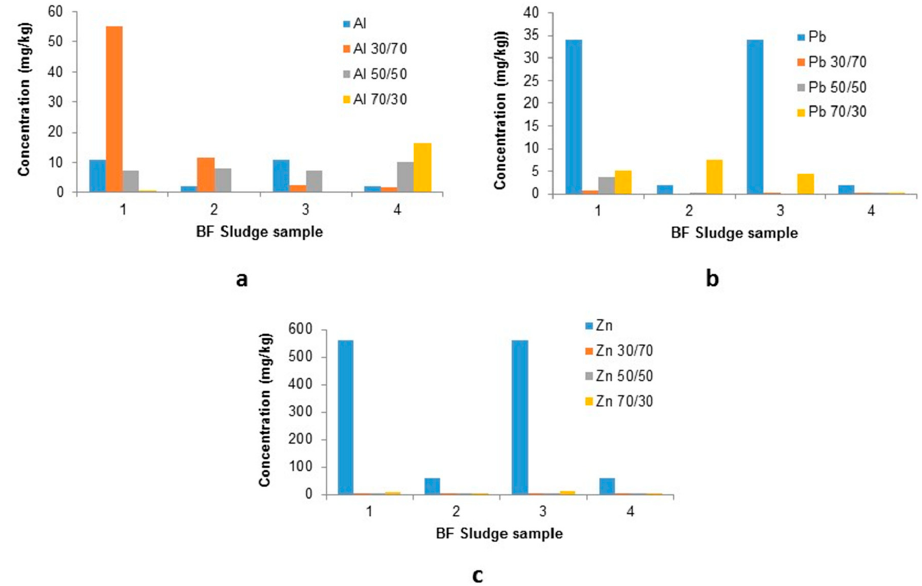
Figure 8. leachate concentrations in stabilised moulds compared to raw sinter ESP dusts: ( a ) Al; ( b ) Pb; and ( c ) Zn.